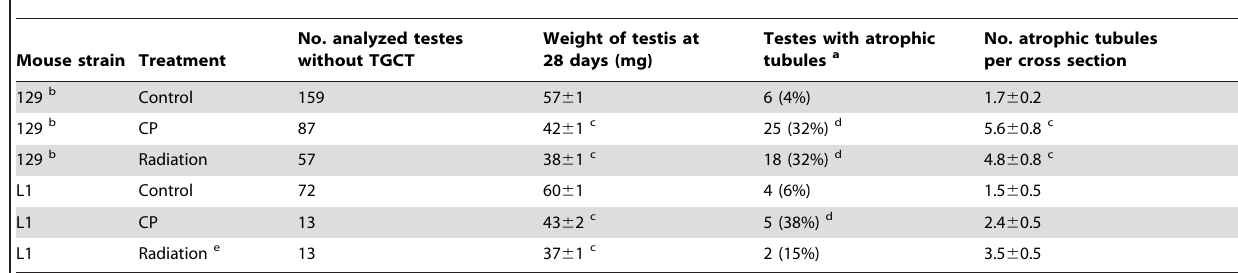
Table 3. Reproductive toxicity in male 129 and L1 mice exposed to cyclophosphamide (CP) or radiation in utero .